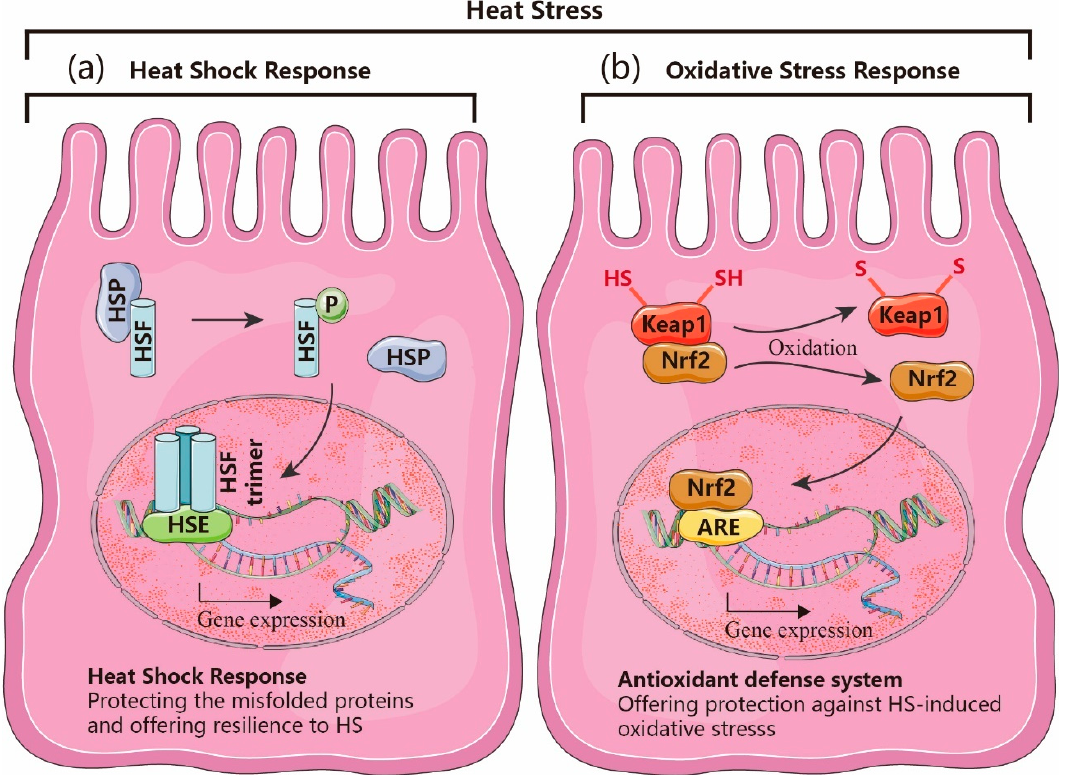
Figure 2. Schematic illustration of the heat stress (HS)-induced heat shock response and oxidative stress response. ( a ) Cells under HS conditions activate the heat shock response pathway, which is initiated by translocation and trimerization of heat shock factor-1 (HSF1) into the nucleus, where it binds to the regulatory heat shock elements (HSE) in the promoter regions of heat shock protein (HSP) genes. ( b ) Oxidative stress induced by HS results in the liberation of nuclear factor erythroid 2 related factor 2 (Nrf2) from Kelch-like ECH-associated protein 1 (Keap1) and the translocation of Nrf2 into the nucleus where it binds to the antioxidant response element (ARE) in the promotor region of antioxidant target genes, driving their expression.